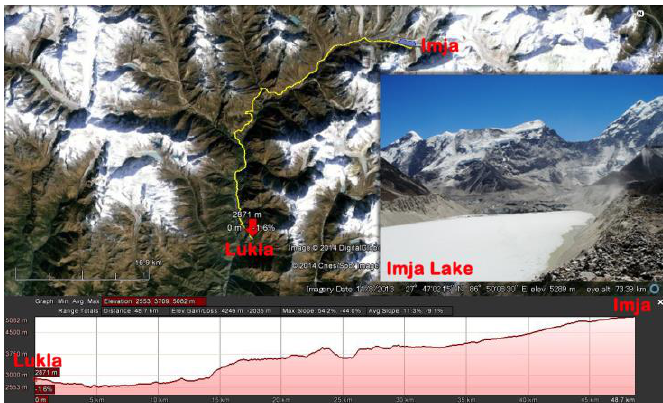
Figure 2 Fieldwork route to Imja Lake